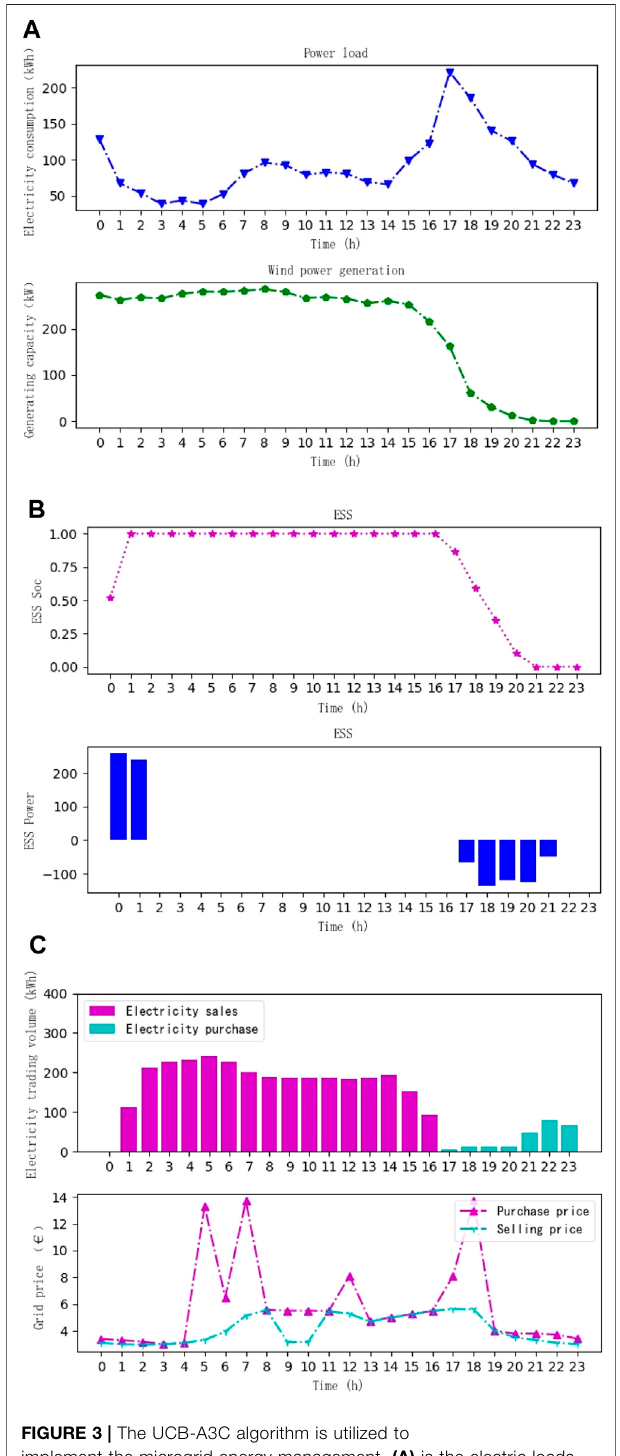
FIGURE 3 | The UCB-A3C algorithm is utilized to implement the microgrid energy management, (A) is the electric loads and distributed energy resource, (B) is the energy storage system, (C) is the electricity transaction volume and price change.